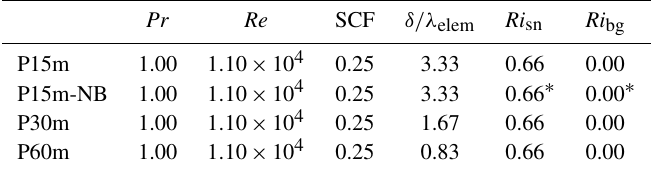
Table 1. Dimensionless parameter values. Overview of the values of the dimensionless parameters applied during the simulations.